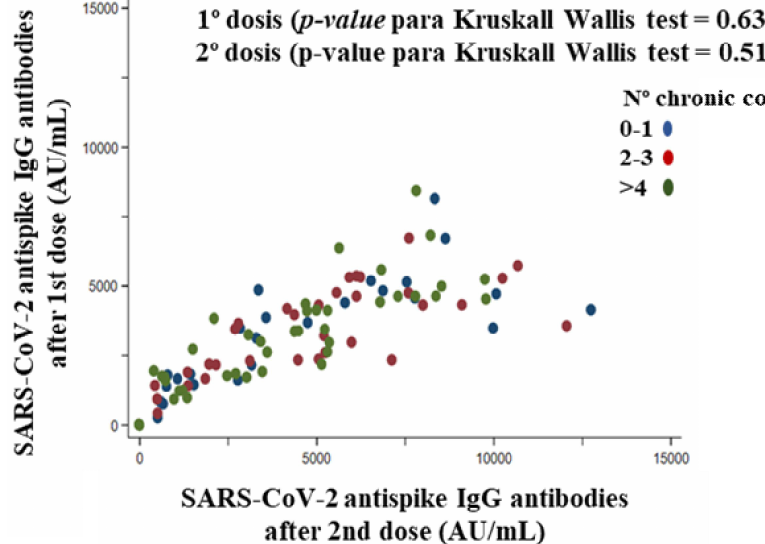
Figure 6. Correlation between total SARS-CoV-2 anti-spike IgG antibody titer (AU/mL) after the first dose and IgG antibody titer (AU/mL) after the second dose stratified by blood group of the participants.